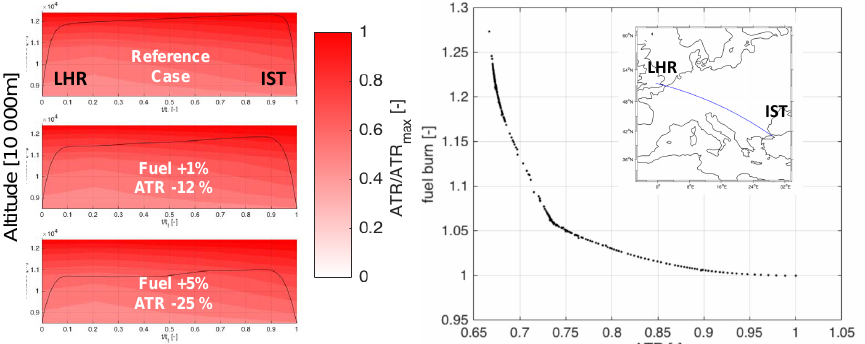
Figure 7. Evaluation of fuel-optimal versus climate-optimal solution, by using prototype ECFs for flight from London Heathrow (LHR) to Istanbul (IST) showing Pareto front ( right ). Trajectories ( left ) for reference case ( top ), fuel increase of 1% ( middle ) and 5% ( bottom ) with relative strength of total ATR shown as